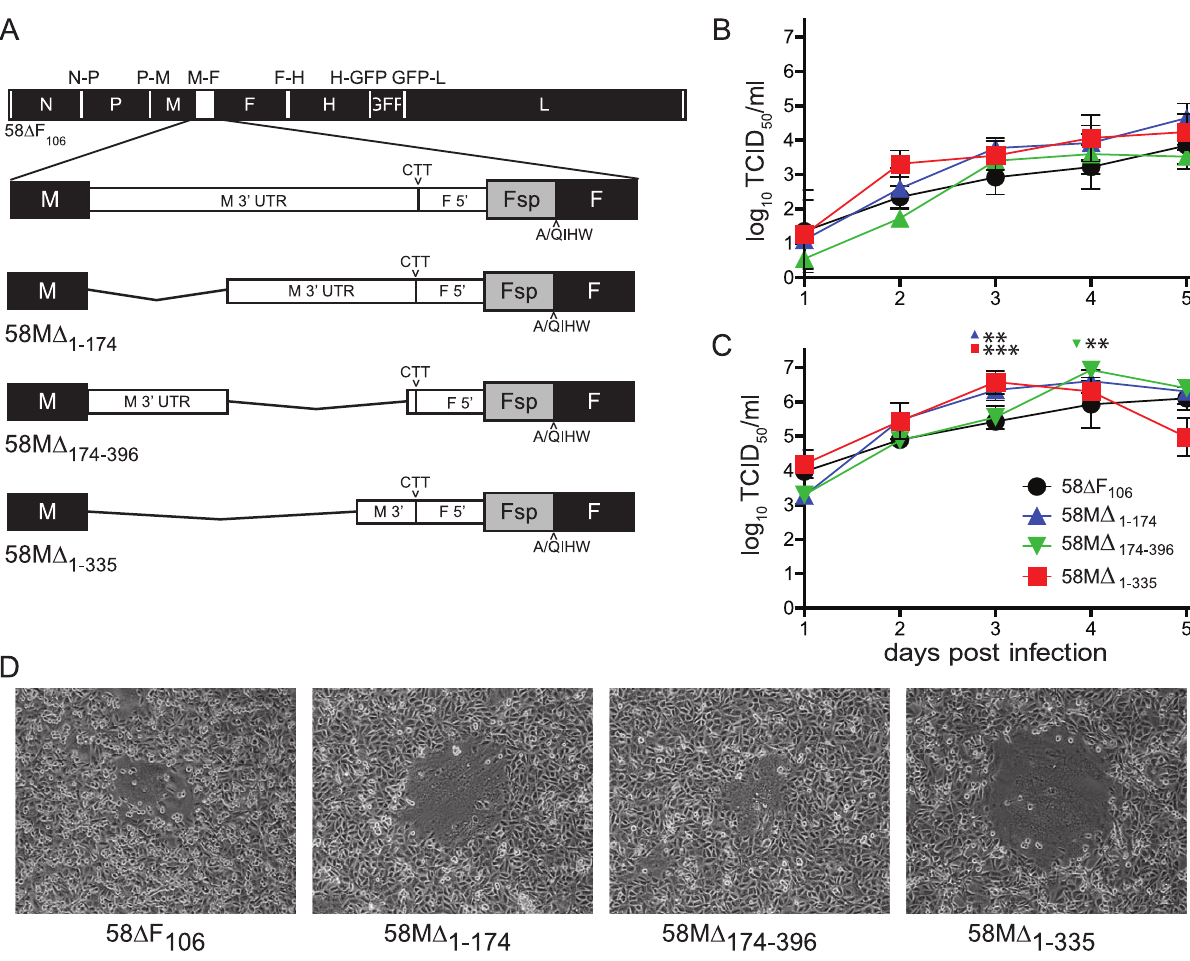
Figure 3. Generation and characterization of recombinant CDVs with alterations in the M 3 9 UTR. ( A ) Schematic drawing of recombinant viruses produced. The recombinant 58 D F 106 genome is drawn to scale. Black and white boxes represent open reading frames and UTRs, respectively. The genes are indicated by their respective abbreviation. The M-F region of the recombinant viruses is expanded below. The UTRs are indicated by a thinner box, and the signal peptide coding region of the F gene (Fsp) is shaded. ( B and C ) Growth curves of the parental 58 D F 106 and the three recombinant viruses in VerodogSLAMtag cells expressed as titers of released ( B ) and cell-associated virus ( C ). Cells were infected with an MOI of 0.01, and samples were harvested daily for five days. Titers are expressed as TCID 50 and error bars indicate the standard deviation. **, P , 0.01, and ***, P , 0.001. ( D ) Syncytia formation in VerodogSLAMtag cells. Cells were infected with a MOI of 0.01 and overlaid with 0.5% methylcellulose. Photographs show a representative syncytia of one replicate taken 48 h post infection using phase contrast at 100 6